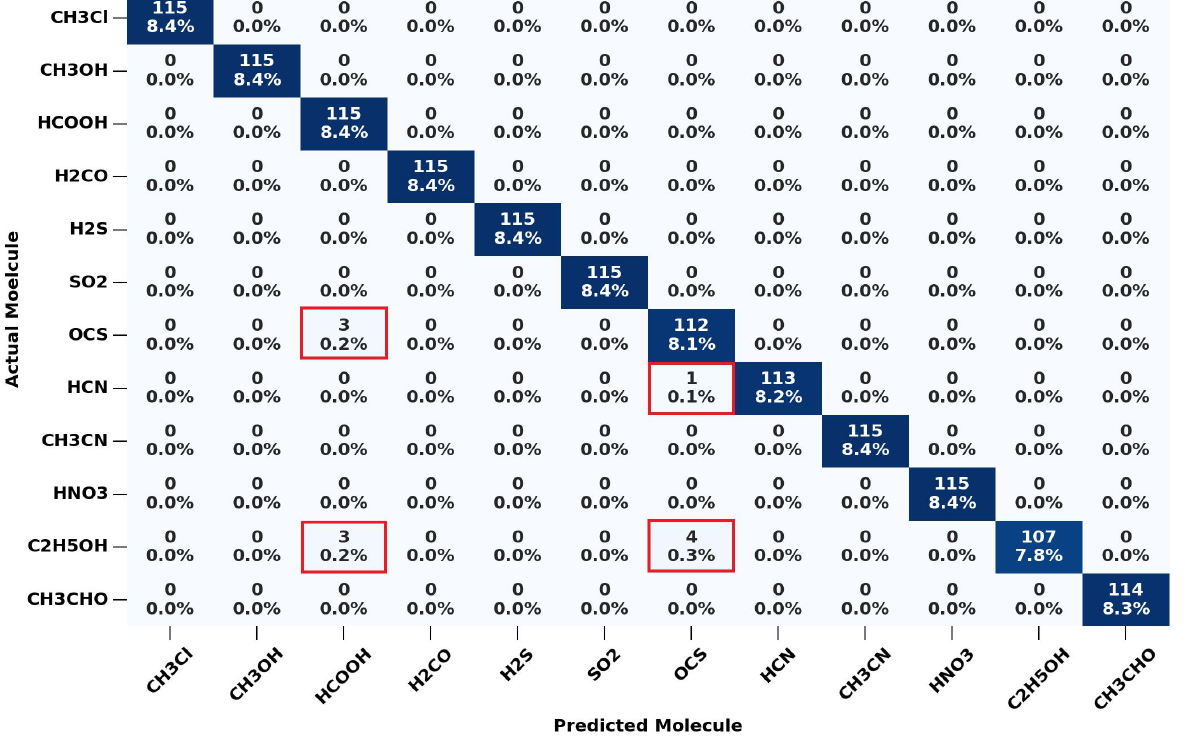
Figure 7. Confusion matrix for classification of 1377 simulated training spectra. Red boxes indi- cate misclassifications.